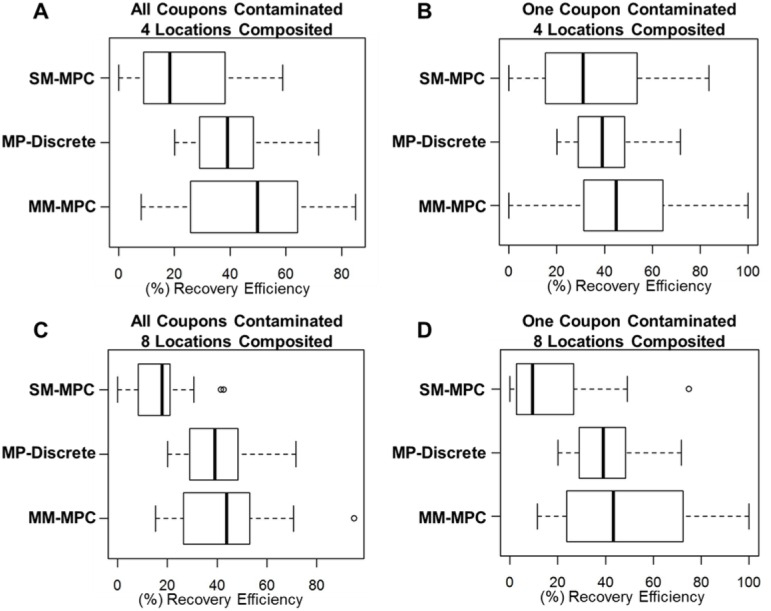
The composite methodology is significant, and the MM-MPC method yields the highest RE when considering the number of locations composited and number of coupons contaminated.The four scenarios tested were 4 samples composited with (A) all or (B) one random coupon contaminated and 8 samples composited with (C) all or (D) one random coupon contaminated. The process control, MP-Discrete, data is included for comparative purposed for the composite methods.